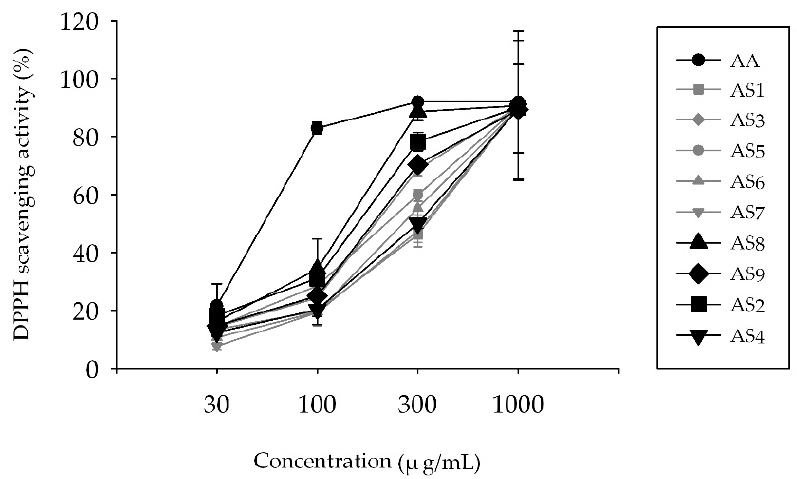
Figure 2. DPPH radical scavenging activity of AS extracts (AS1–AS9). X-axis: concentration of applied compound, Y-axis: DPPH radical scavenging activity (%). The results are presented as the mean ± S.D. of experiments ( n = 6).